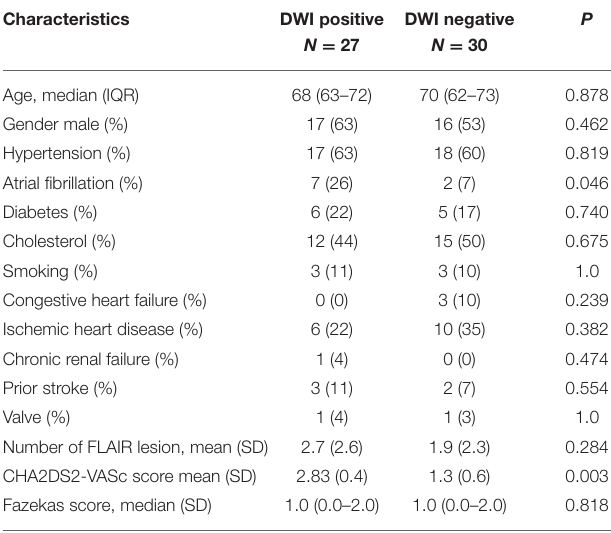
TABLE 1 | Comparison of clinical parameters between patient groups with lesions seen in DWI (positive) vs. without (negative).